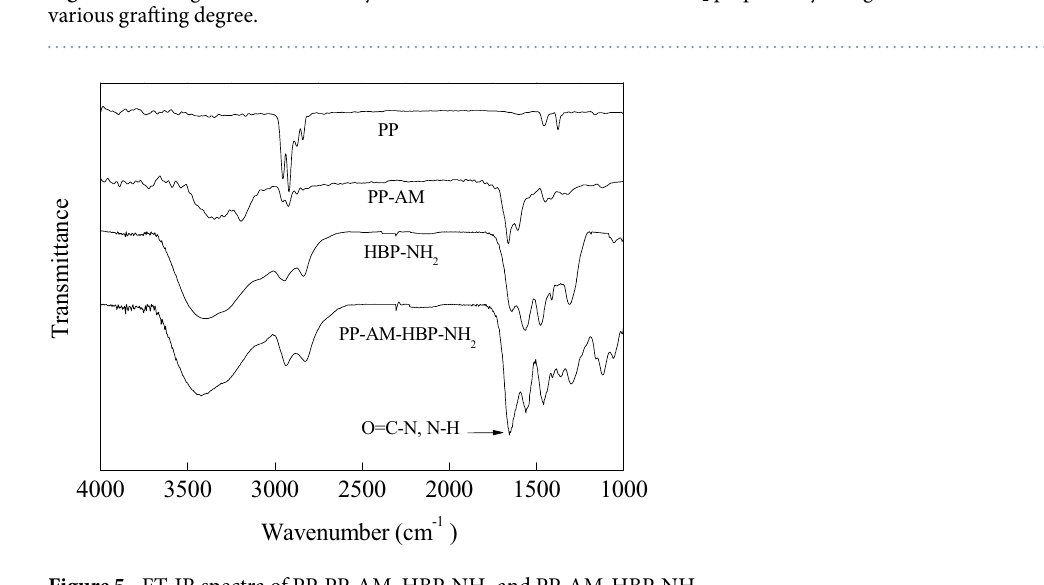
Figure 5. FT-IR spectra of PP, PP-AM, HBP-NH 2 and PP-AM-HBP-NH 2